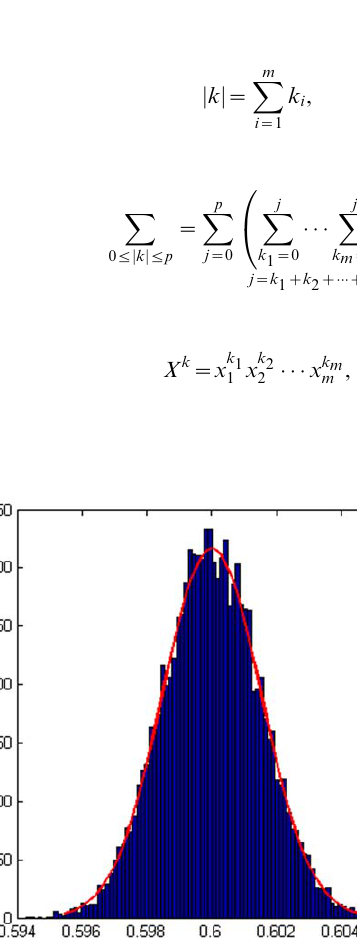
Figure 4. Histogram and asymptotic distribution for ^ bb 0 of GLS when the variance function of the error term is s 2 ( x 1 , x 2 ) ~ exp ( { ( x 1 z x 2 )) .